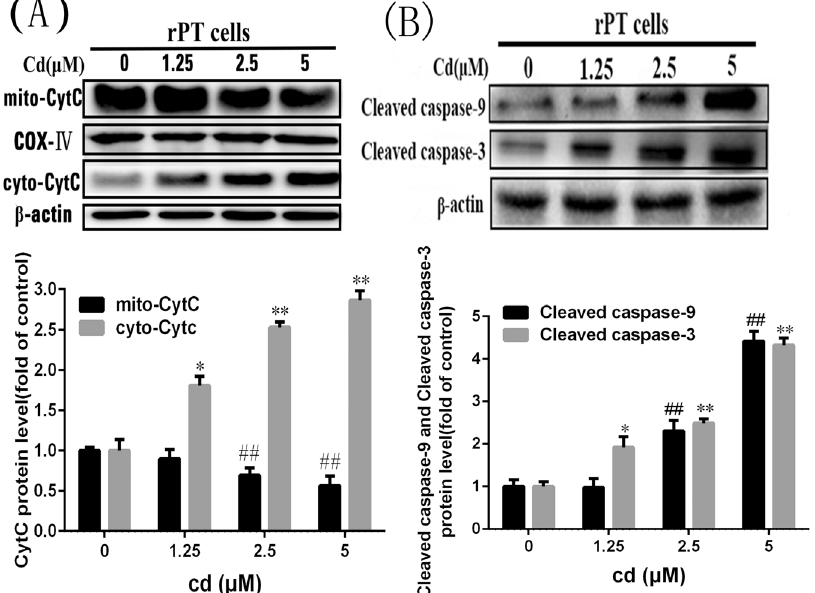
Figure 6. Effect of cadmium on the mitochondrial apoptosis pathway. Western blot analysis of the release of Cyt C protein and the expression of Cleaved caspase-9/3 in primary rPT cells after treated with 1.25, 2.5 or 5 μ M Cd for 12 h. ( A ) Compared with the control group, the release amount of Cyt C increased gradually. ( B ) Compared with the control group, the expression of Cleaved caspase-9 and Cleaved caspase-3 increased gradually. The quantitative analysis was performed on the western blotting results of three independent experiments (mean ± SD, n = 3). Respectively, * P < 0.05; ** P < 0.01 vs. the control group by one-way ANOVA. ## P < 0.01 vs. the Cd group by one-way